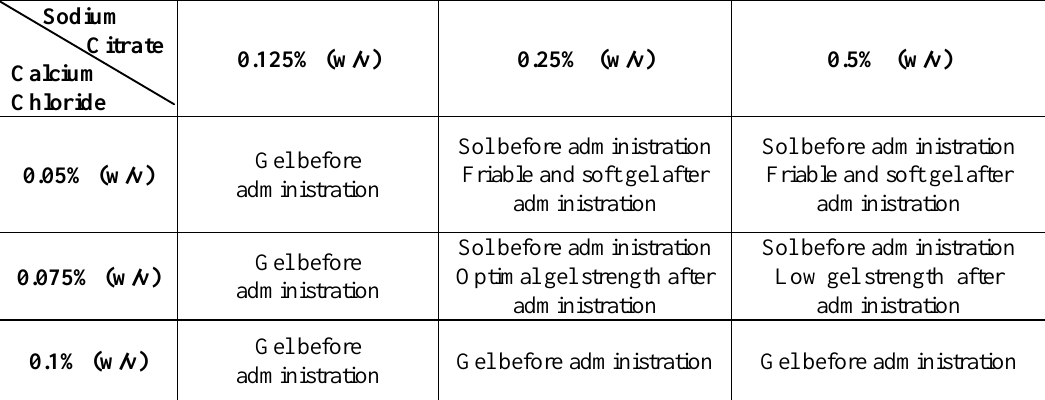
Table (1): The effect of different concentrations of sodium citrate and calcium chloride on the gelation of 1% (w/v) pectin sols before and after administration to simulated gastric fluid. Sodium